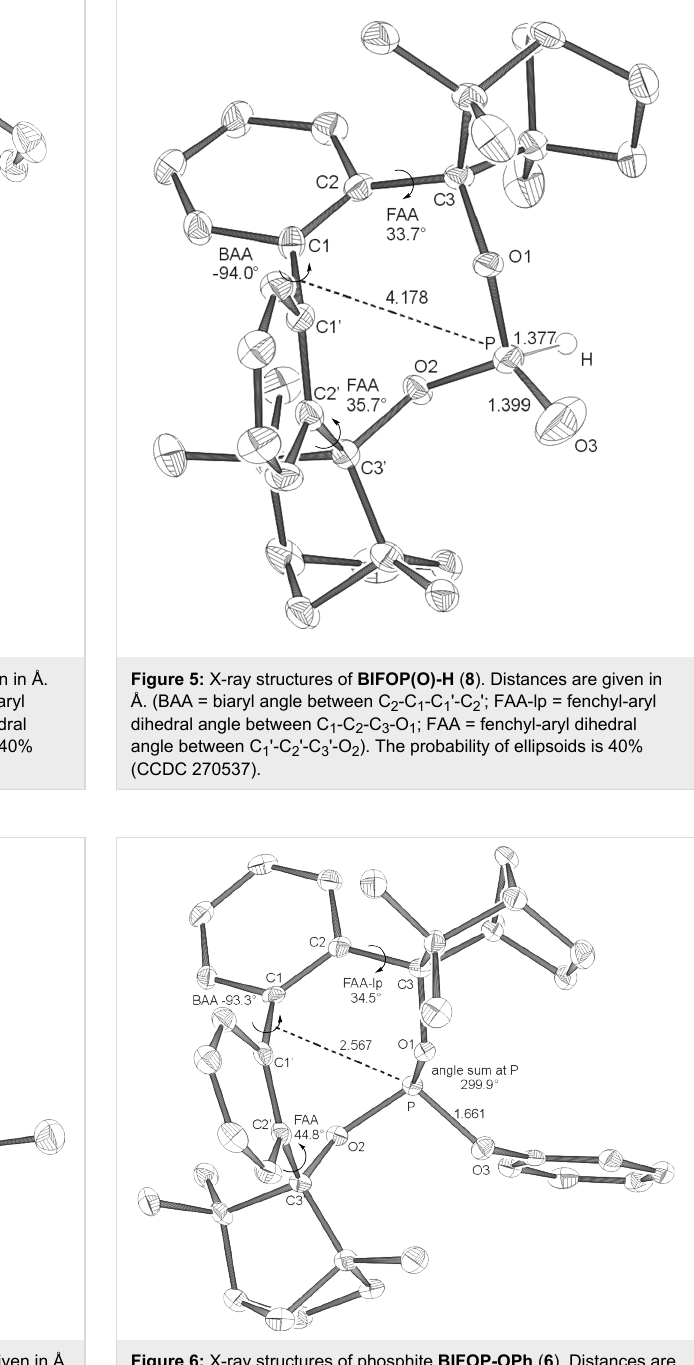
C 1' , Scheme 4). The tightest encapsulation and fenchane embed- ding of phosphorus atoms is apparent for the halophosphites BIFOP-Cl ( 1 , 2.471 Å) and BIFOP-Br ( 2 , 2.476 Å, Table